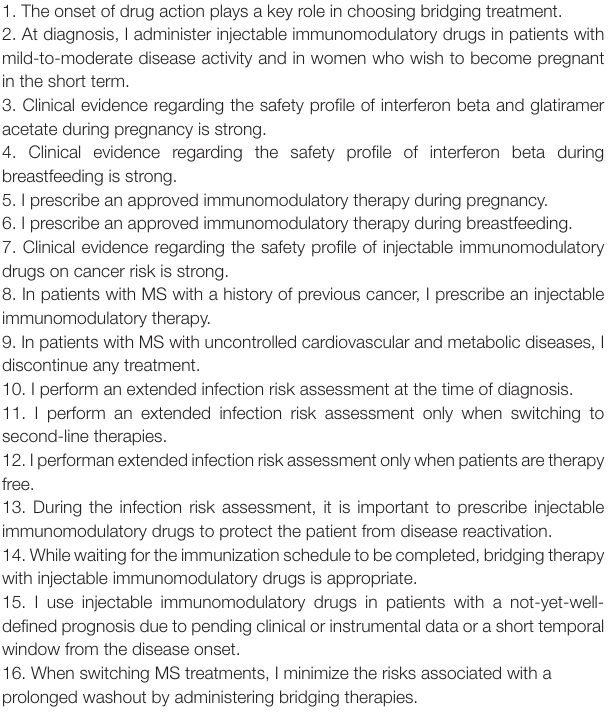
TABLE 1 | A Delphi